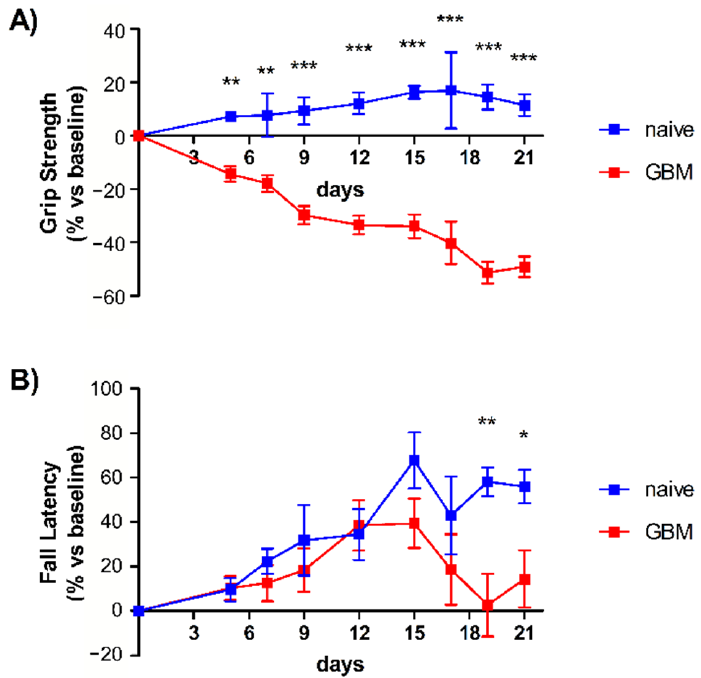
Figure 1. Motor tests and assessment of tumor progression. ( A ) Grip strength test. GBM mice (red line, n = 6) displayed a significant deterioration of grip strength starting from day 5 with respect to naïve mice (blue line, n = 9), which instead showed a slight improvement in task performance over the time course of the study and in accordance with data previously reported. ( B ) Rotarod test. Both groups showed an increase in their motor performance until day 12 due to the learning component of this motor task [25]. However, from day 15, after tumor induction, the GBM mice (red line, n = 6) exhibited worse performance, indicative of significant motor dysfunction with respect to naïve animals. Data are expressed as mean ± SEM. * p < 0.05, ** p < 0.01, *** p < 0.001 using a two-way repeated-measures ANOVA with Holm–Sidak post hoc correction.